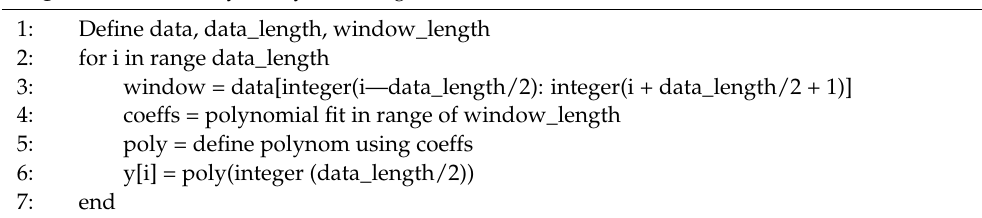
Algorithm 2: Savitzky-Golay Filter Algorithm